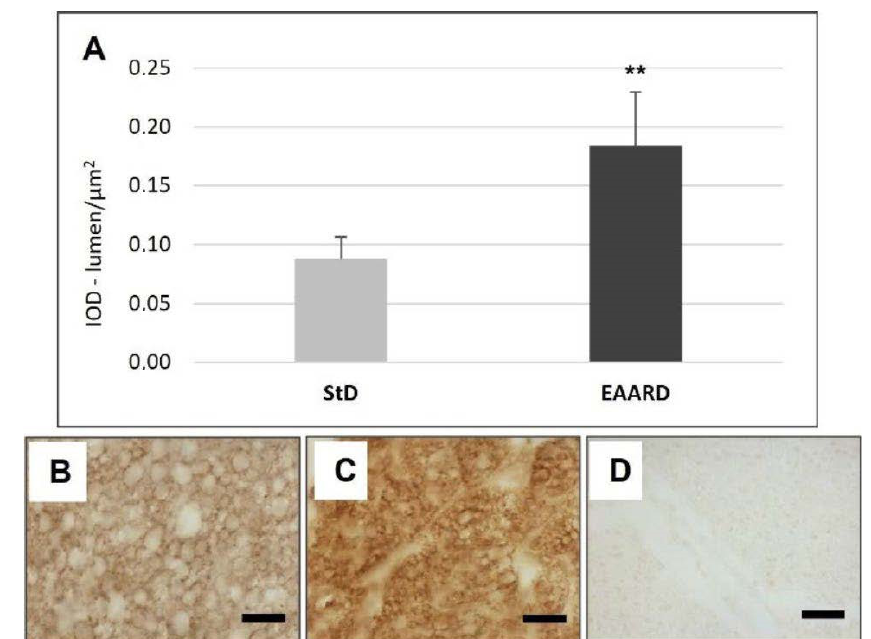
Figure 12. ( A ): Optical density for SIRT-3 immunostaining in BAT ( t = 5.44, p = 0.000) according to diets (mean ± sd). ** p < 0.01. ( B , C ): Representative images of BAT IHC in StD and EAARD-fed mice, respectively. ( D ): Negative control performed by omitting the primary antibody. Original magnifi- cation 20×; scale bar 50 μm.